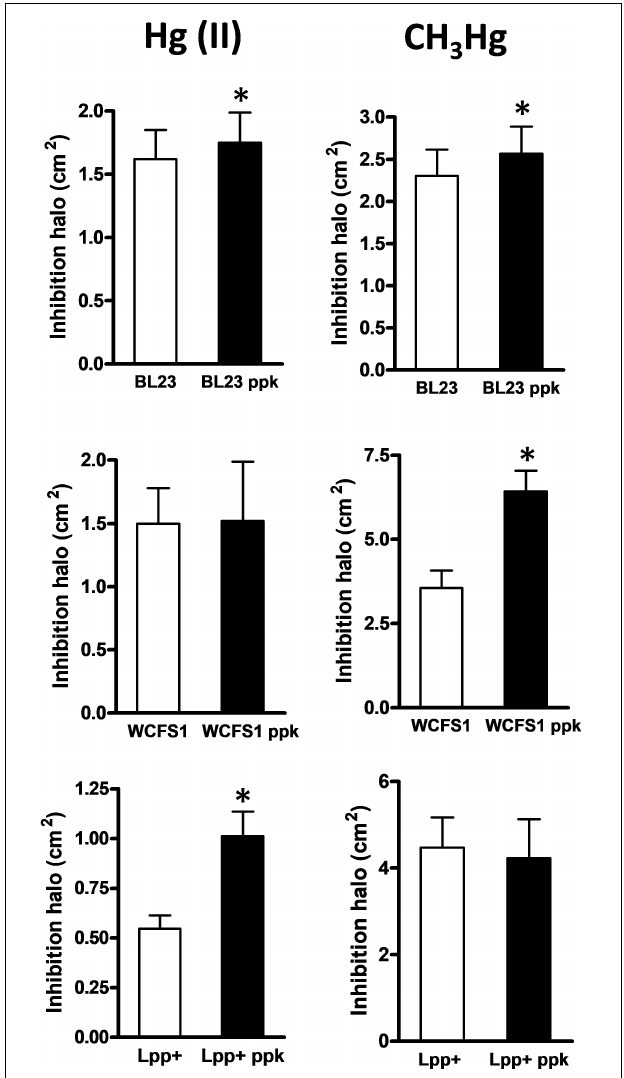
FIGURE 2 | Growth inhibition by mercury in Lactobacillus strains and their respective ppk mutants. The graphs represent the areas of the inhibition halos produced by inorganic [Hg(II), left column] and organic (CH 3 Hg, right column) mercury in wild type and ppk strains. Data are means plus standard deviations ( n = 20–55). The asterisks indicate a significant difference ( p <